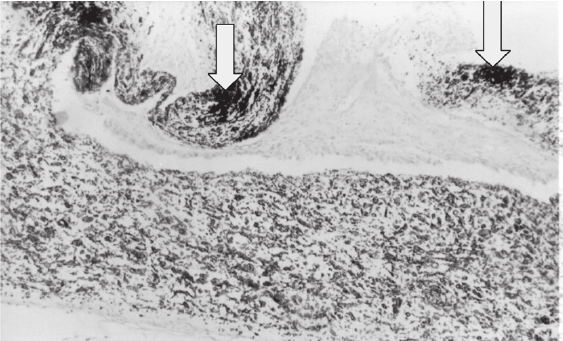
Fig. 1 - Fotomicrografia mostrando corte transversal da cúspide aórtica tratada com glutaraldeído, com sinais de importante calcificação após 15 dias de implante. GDA subgrupo 15 dias (von Kossa